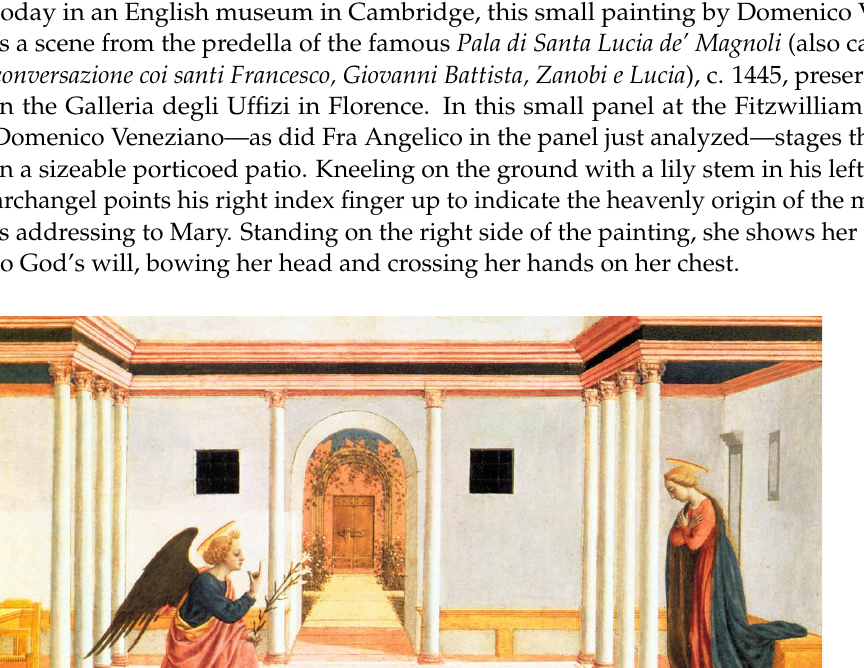
Figure 6. Benozzo Gozzoli, The Annunciation , c. 1445. A scene of the predella of the Madonna della Cintola altarpiece. Pinacoteca Vaticana. Fra Filippo Lippi poses The Annunciation ( L’Annunciazione Doria ), c. 1445–1450, from the Galleria Doria-Pamphilj in Rome (Figure 7), with some compositional novelties: for example, the inversion of the position of the two protagonists, with Gabriel on the right